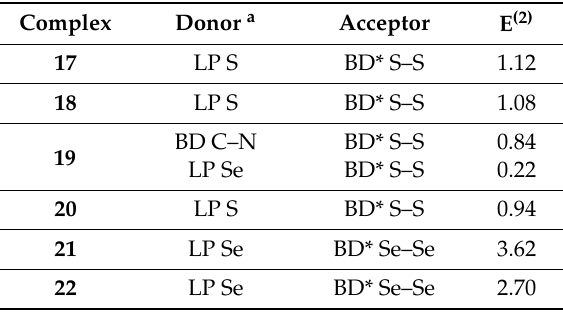
Table 2. Donor and acceptor natural bond orbital (NBO) interactions with indication of the second-order interaction energy E (2) (kcal/mol) for complexes 17 – 32 .